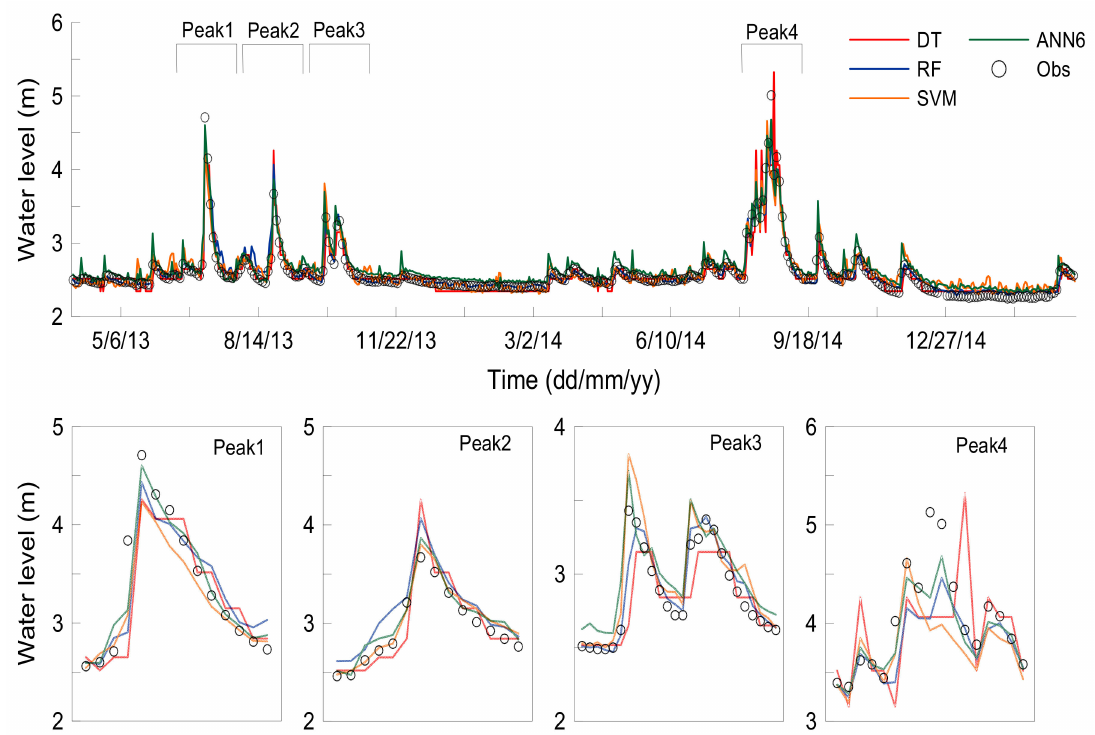
Figure 13. Time series of simulated and observed water level for test period (from 1 April 2013 to 31 March 2015). Four peak values (6 July 2013, 25 August 2013, 11 October 2013 and 22 August 2014) were selected for peak level